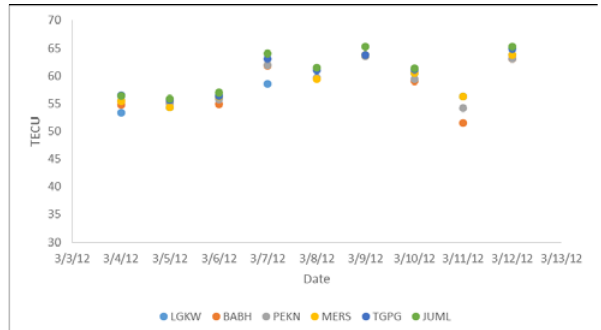
Figure 5. The variation of TEC (in TECU) changes during flare X5.4 for all selected MyRTKnet stations from 3 rd – 12 th March 2012 using GPS_TEC.